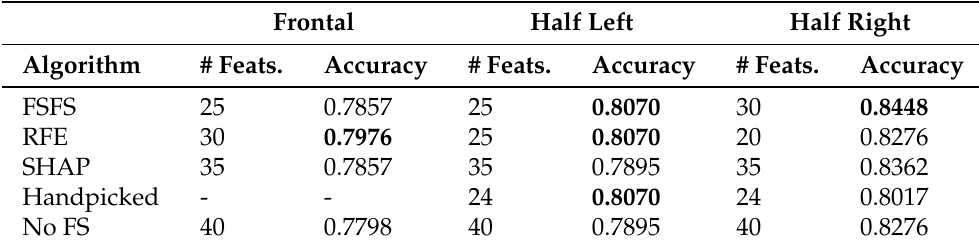
Table 2. The highest validation set accuracy per algorithm for each pose model together with the amount of selected features. Handpicked means manually excluding right and left orientated features, for left and right poses, respectively. Best results per column are shown in bold . Frontal Half Left Half